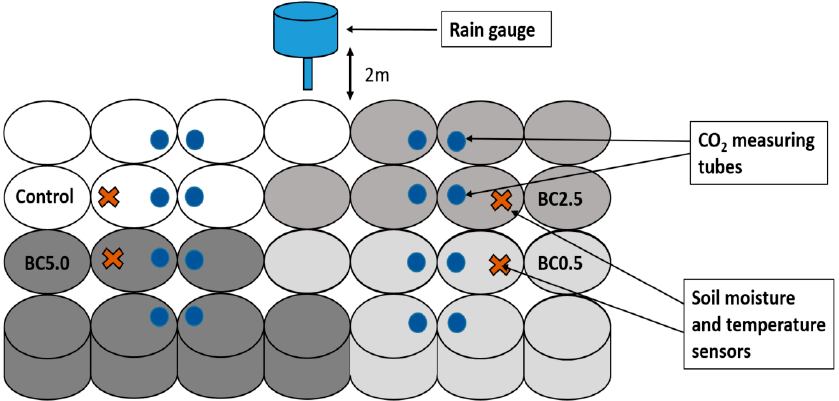
Figure 1. Schematics of the experimental setup.